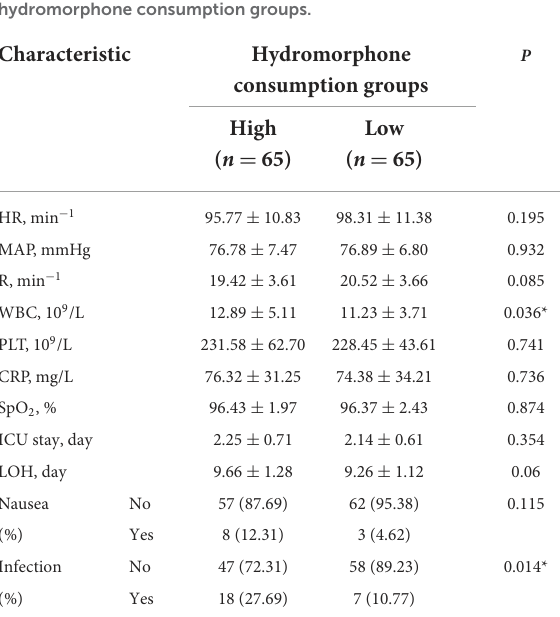
TABLE 2 Comparison of clinical outcomes between the two hydromorphone consumption groups.